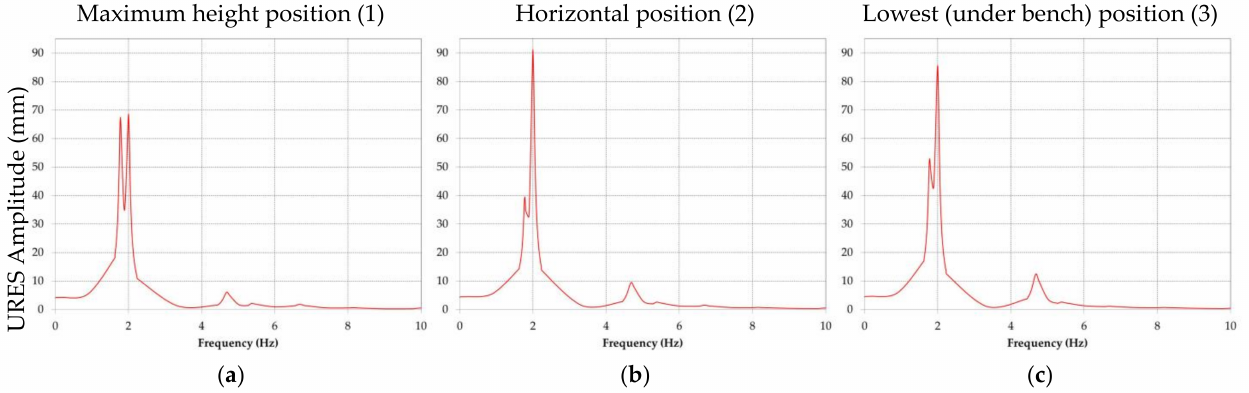
Figure 16. Comparative results of the resultant amplitude of the displacement for all directions, positions (1), (2) and (3) of the BWE boom.